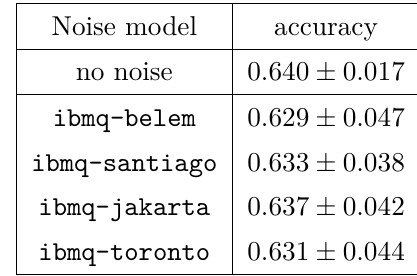
Table 3. Accuracy for noisy circuits obtained with the muon dataset